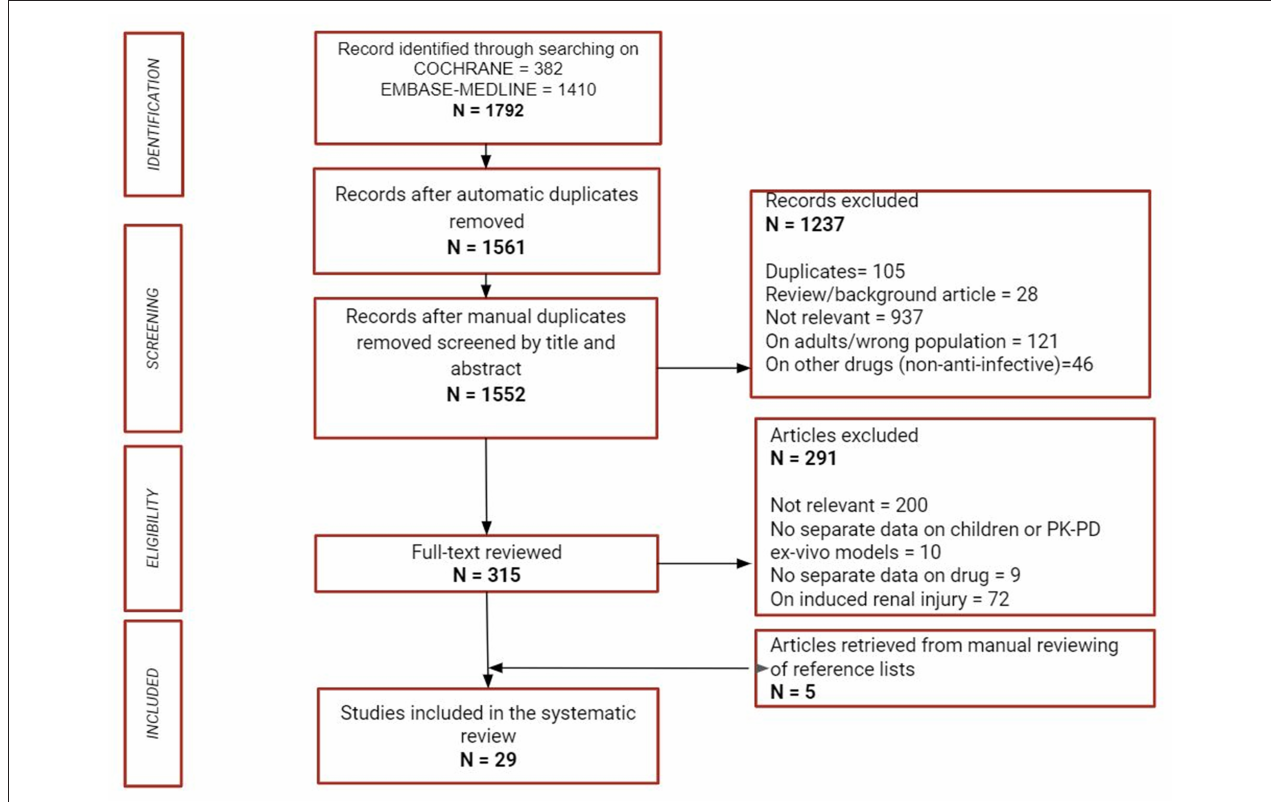
FIGURE 1 | Flow chart of the study selection process.